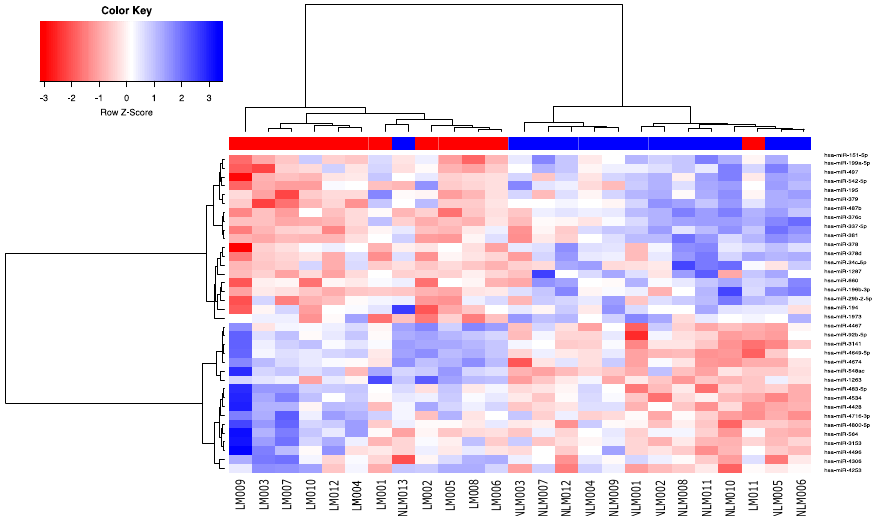
Figure 1 . Heatmap of the supervised hierarchical clustering analysis of the 36 miRNAs expressed in the lymph node-positive group and the control group. The 12 samples in red exhibited lymph node metastasis (LNM), and the 13 samples in blue did not exhibit LNM.